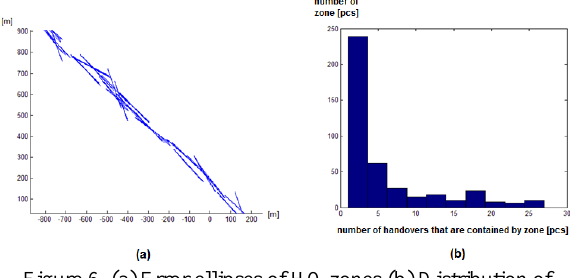
Figure 6. (a) Error ellipses of HO zones (b) Distribution of numbers of HO in